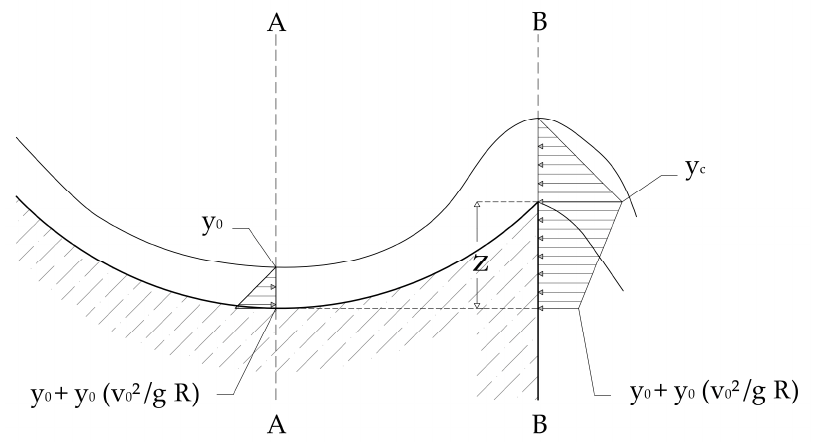
Figure 3. Head of pressure laws on the initial and final sections at the moment of the jet flow initiation.